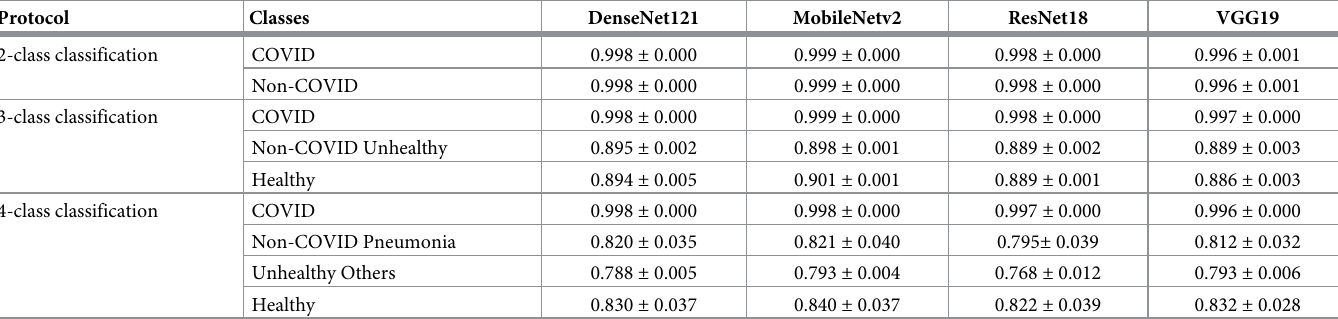
Table 6. Class-wise AUC corresponding to existing deep learning algorithms for all four classification